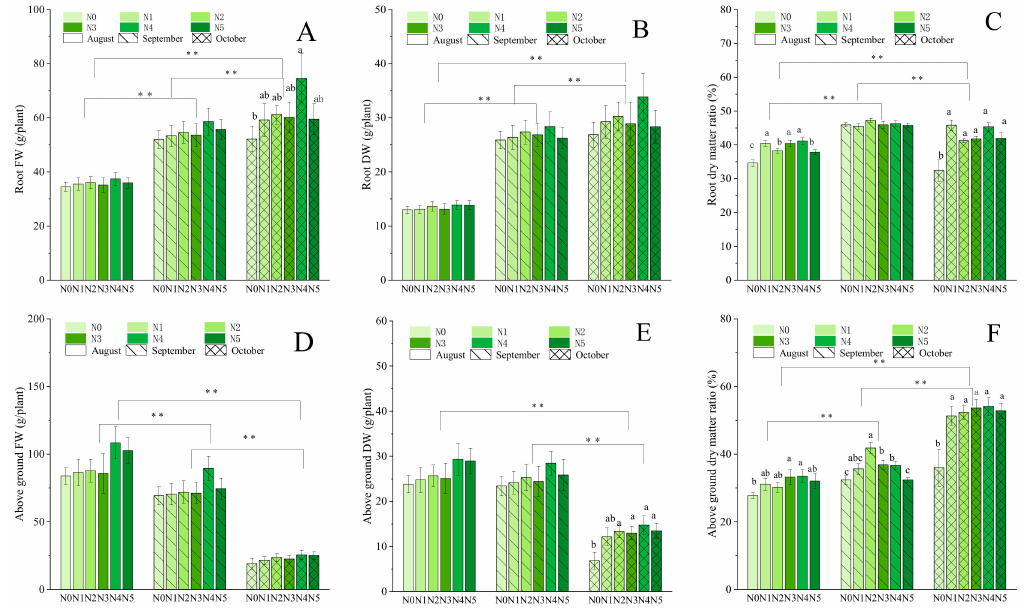
Figure 2. Fresh weight (Fw, g / plant), dry weight (Dw, g / plant), and dry matter ratio (%) of roots and aboveground parts in response to di ff erent nitrogen levels: 0 kg / ha (N0, control), 37.5 kg / ha (N1), 75 kg / ha (N2), 112.5 kg / ha (N3), 150 kg / ha (N4), and 187.5 kg / ha (N5), and harvest stages from August to October. ( A ) Root Fw from August to October; ( B ) root Dw from August to October; ( C ) root dry matter ratio from August to October; ( D ) aboveground Fw from August to October; ( E ) aboveground Dw from August to October; ( F ) aboveground dry matter ratio from August to October, respectively. Significant di ff erences at p < 0.05 are indicated by di ff erent letters. Significant di ff erences at p < 0.01 are indicated by ** between